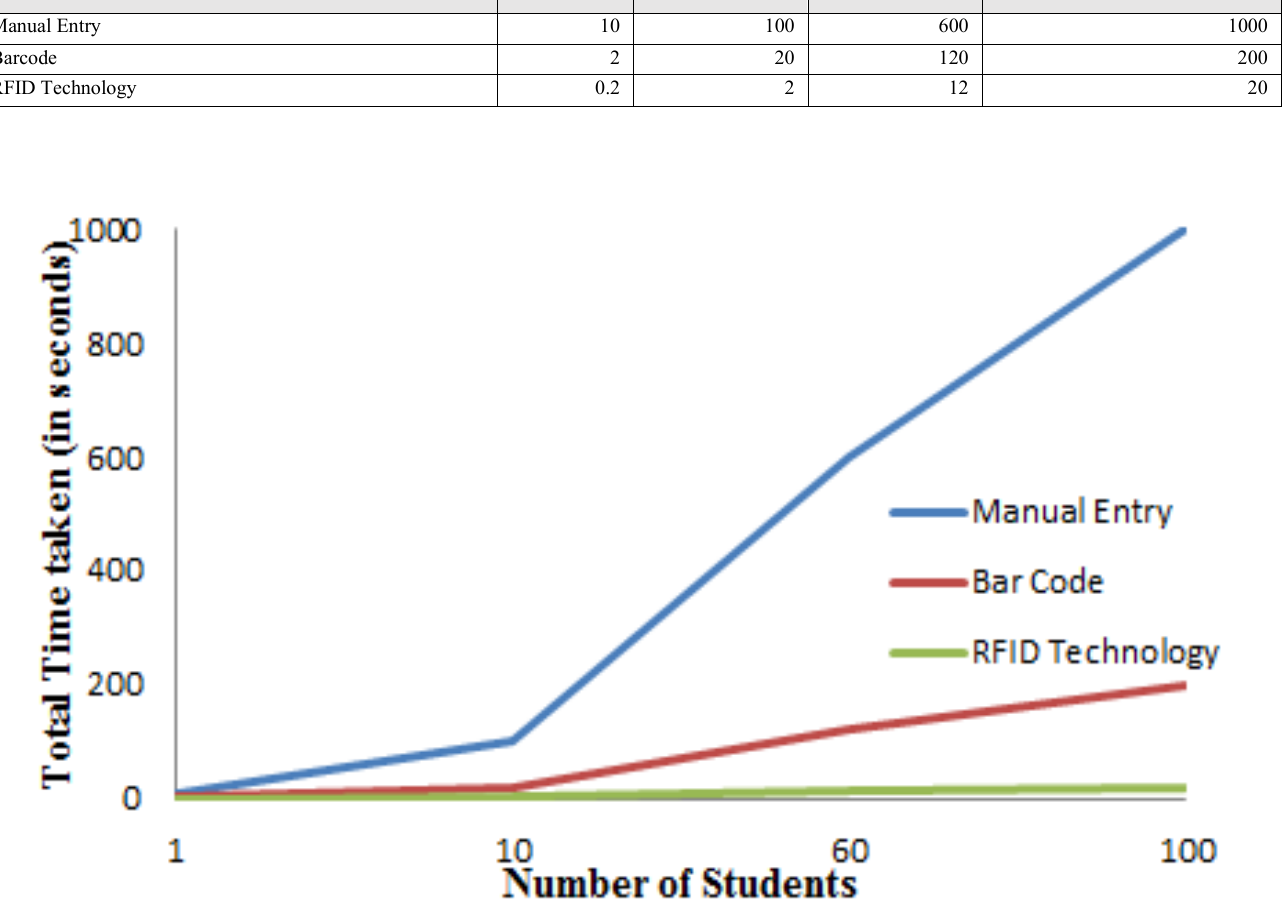
Fig 1.1 Time taken by various